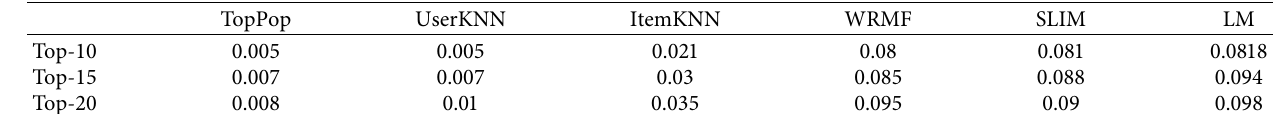
Table 8: Comparison of ARHR indicators on datasets.